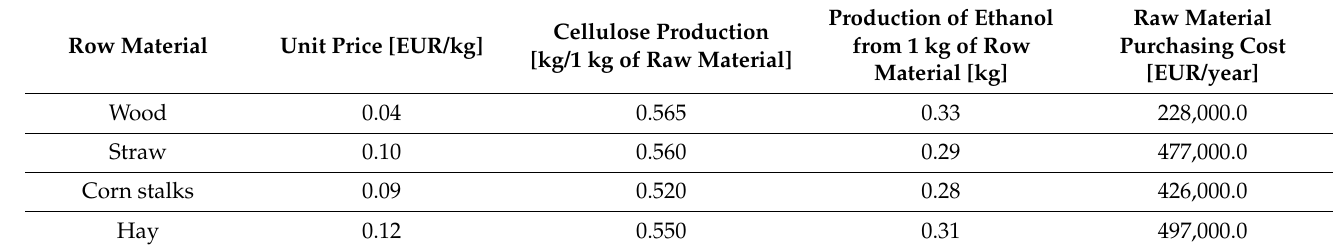
Table 7. Costs of purchasing raw materials for the production of second-generation bioethanol in Poland.